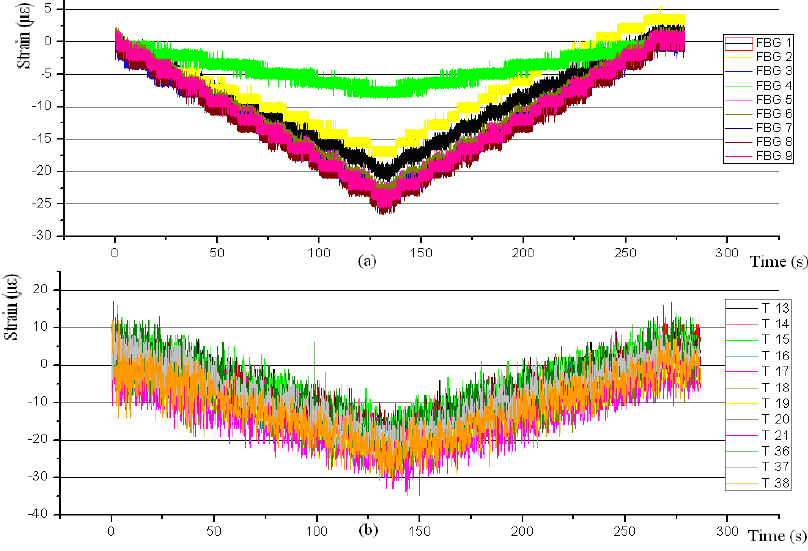
Figure 11. Specimen 2. Test before aging. 5 kN Compression stress. FBGs (a) and strain gauges (b)